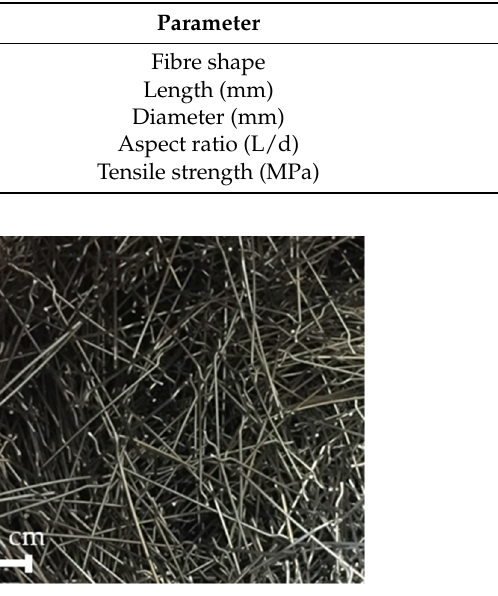
Figure 1. Hooked-end steel fibres used.